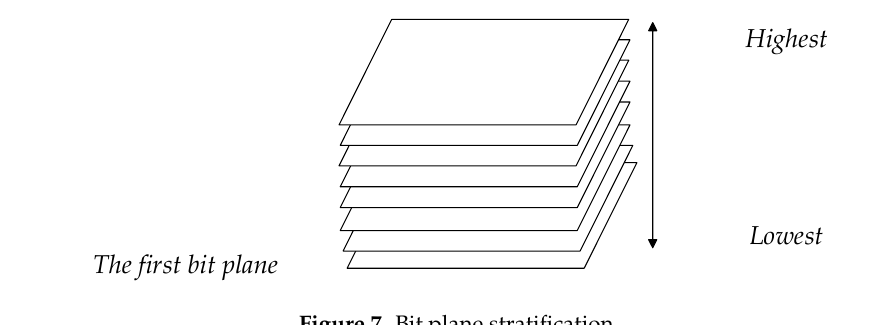
4 of 13 Figure 4. Gray-normalized ROI dorsal hand vein image. In order to obtain the texture contour of dorsal hand vein, gradient based image segmentation method [13] was adopted in this paper. The segmented binary image is shown in Figure 5. Figure 5. The segmented binary image. However, the binary image may lose lots of gray information, therefore, multiplying inverted binary image and normalized gray image to obtain the gray image that only retains the contour of dorsal hand vein, as shown in Figure 6. Figure 6. The gray image that only retains the contour of dorsal hand vein. 2.3. Selection of Bit Plane In order to obtain more abundant gray information and overcome the interference of brightness and noise caused by the collection environment, we studied the bit planes generated by gray image that only retains the contour of dorsal hand vein. The concept of bit planes is now illustrated by a 256-level gray image. If per pixel value of the input gray image is within [0, 255], then each pixel can